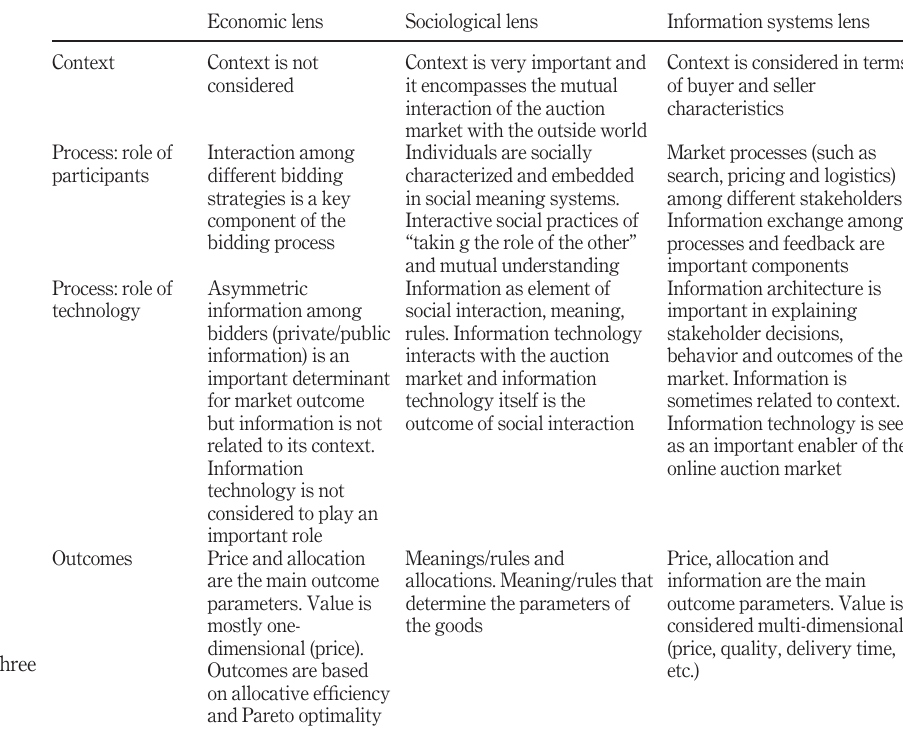
Table 1. Overview of the three theoretical